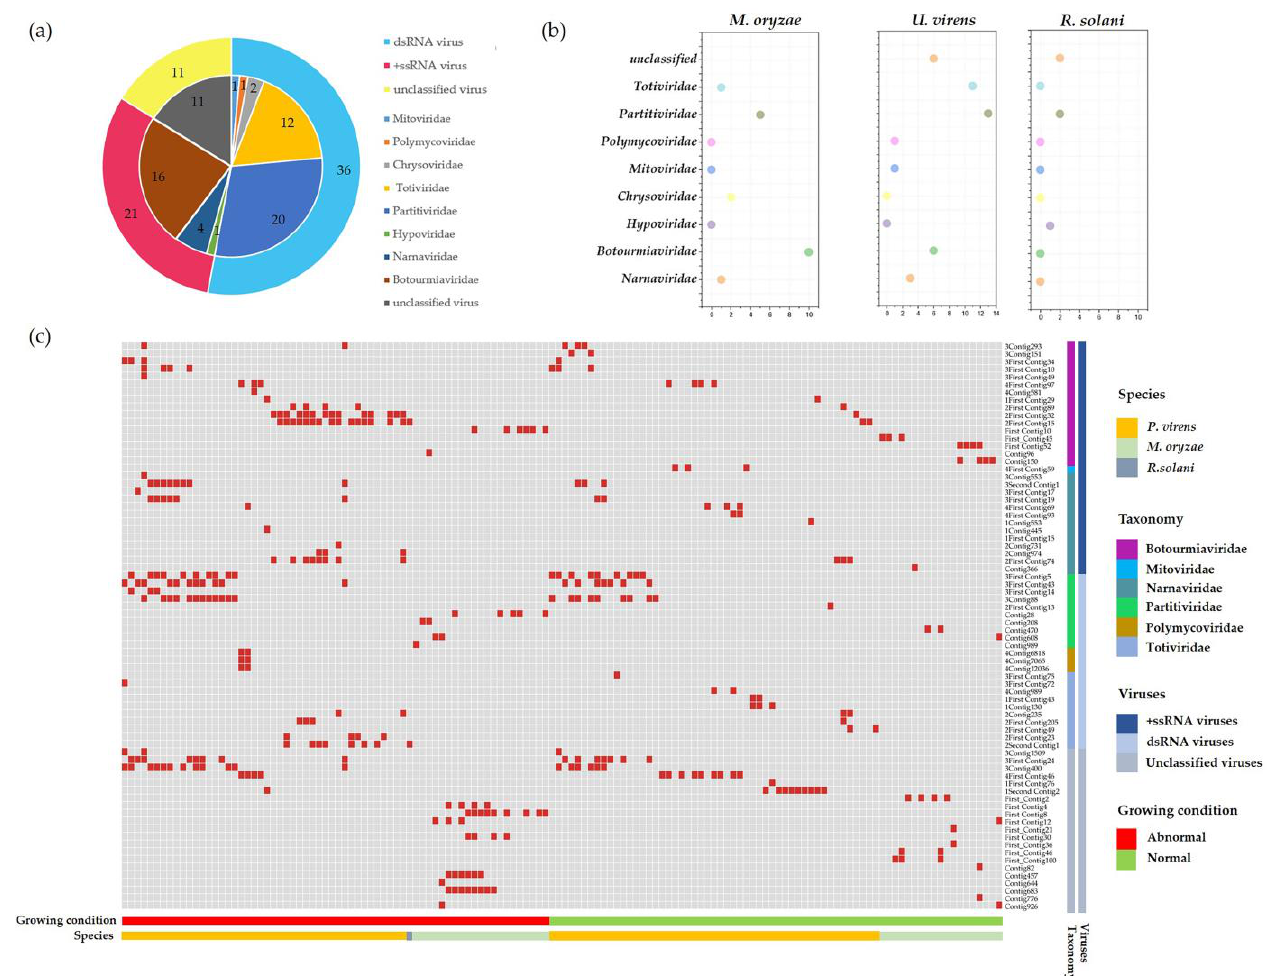
Figure 2. Overview of the virome in the three major fungal pathogens ( P. oryzae , U. virens , and R. solani ) of rice. ( a ) Numbers of mycoviral species in each viral family. ( b ) Prevalence of each viral family in the fungal species tested. ( c ) Distribution of viruses in the three major fungal pathogens of rice. The growth status of the strains was recorded at the time of culturing and reflected in the corresponding colors. Viral species from different viral families are shown, with each viral family indicated by the colors on the heatmap.